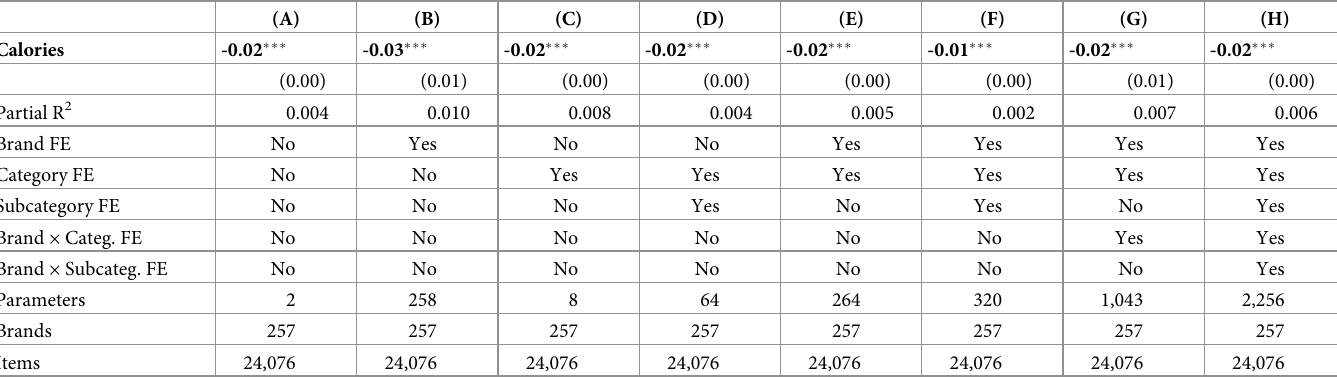
Table 2. Linear regression of RRR value for menu items with different fixed effects (FE) specifications.